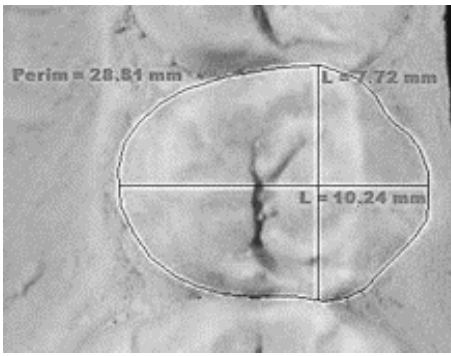
Figure 1. Mesio-distal and bucco-lingual diameter and area measurement presented on an upper premolar.